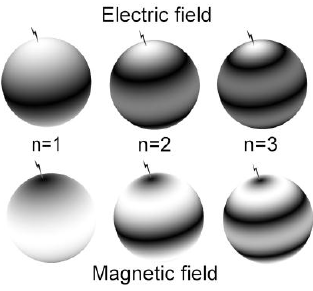
Figure 1. Electric and magnetic fields of the first three SR modes. White shading implies field maximum, while black shading implies field minimun.